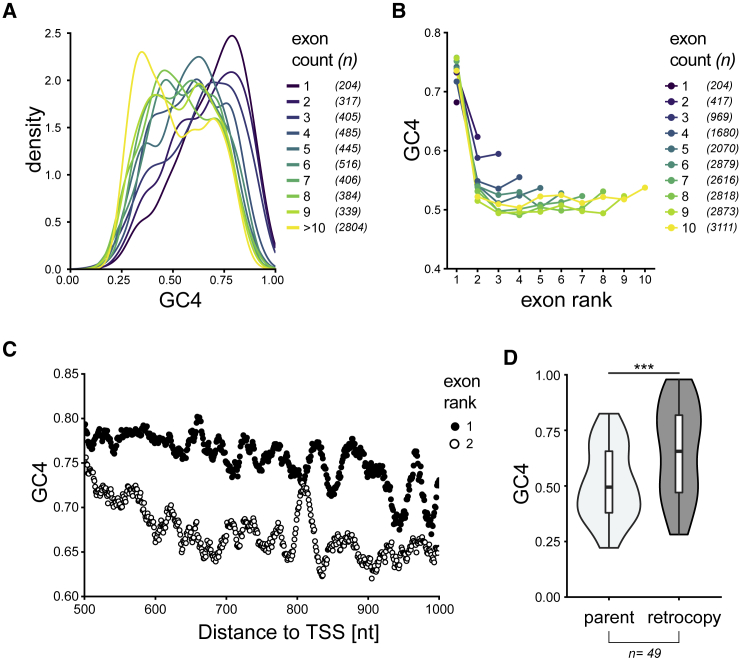
Splicing- and Position-Dependent Patterns of Nucleotide Composition in Human Genes(A) GC4 distribution of human protein-coding genes, grouped by number of exons per gene. The y axis indicates the proportion of genes within a given range of GC4.(B) Mean GC4 content in protein-coding exons, grouped by exon position (rank) and by number of exons per gene.(C) Mean GC4 for individual codons within exons of rank 1 (black dots) or rank 2 (white dots) downstream of the TSS.(D) GC4 distribution of functional retrogenes (dark gray) and their corresponding parental genes (light gray) conserved between mouse and human (p = 2.1 × 10−4, from one-tailed Wilcoxon signed-rank test, n = 49).See also Figure S1.